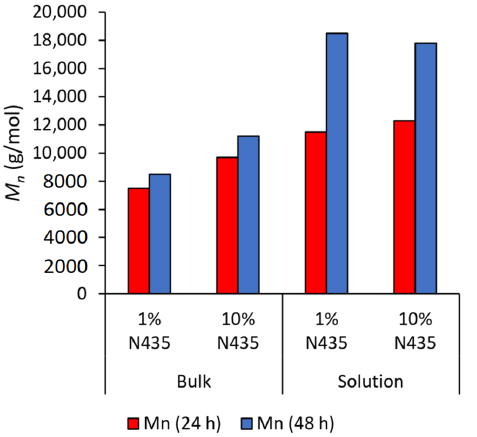
Figure 4. E ff ect of extending polymerization time on M n in both solution and bulk Figure 4. Effect of extending polymerization time on M n in both solution and bulk conditions .